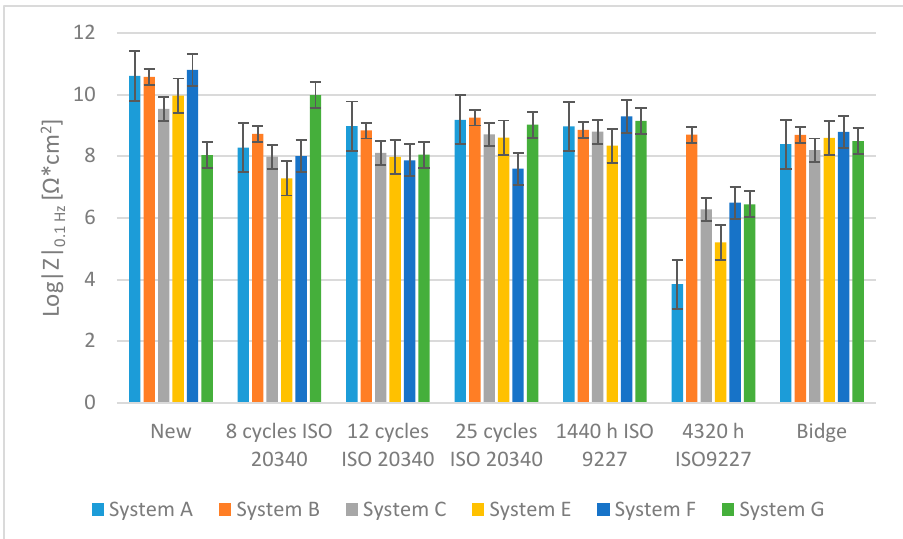
Figure 9. Values of log|Z|0.1 Hz before accelerated tests, after accelerated tests and on the bridges.